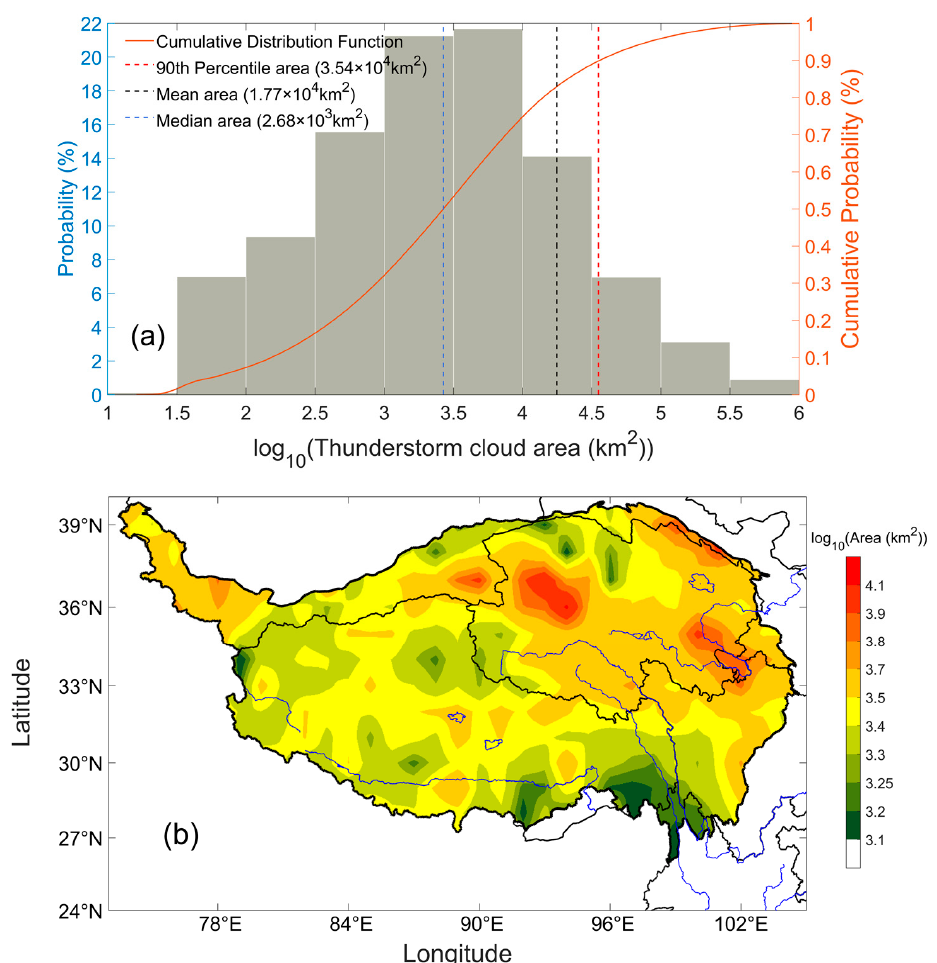
Figure 6. Probability and cumulative probability distributions ( a ) and spatial distribution ( b ) of thunderstorm cloud area over the QTP during the warm season (from May to September). In ( b ), the statistical grid size is 1° × 1°.